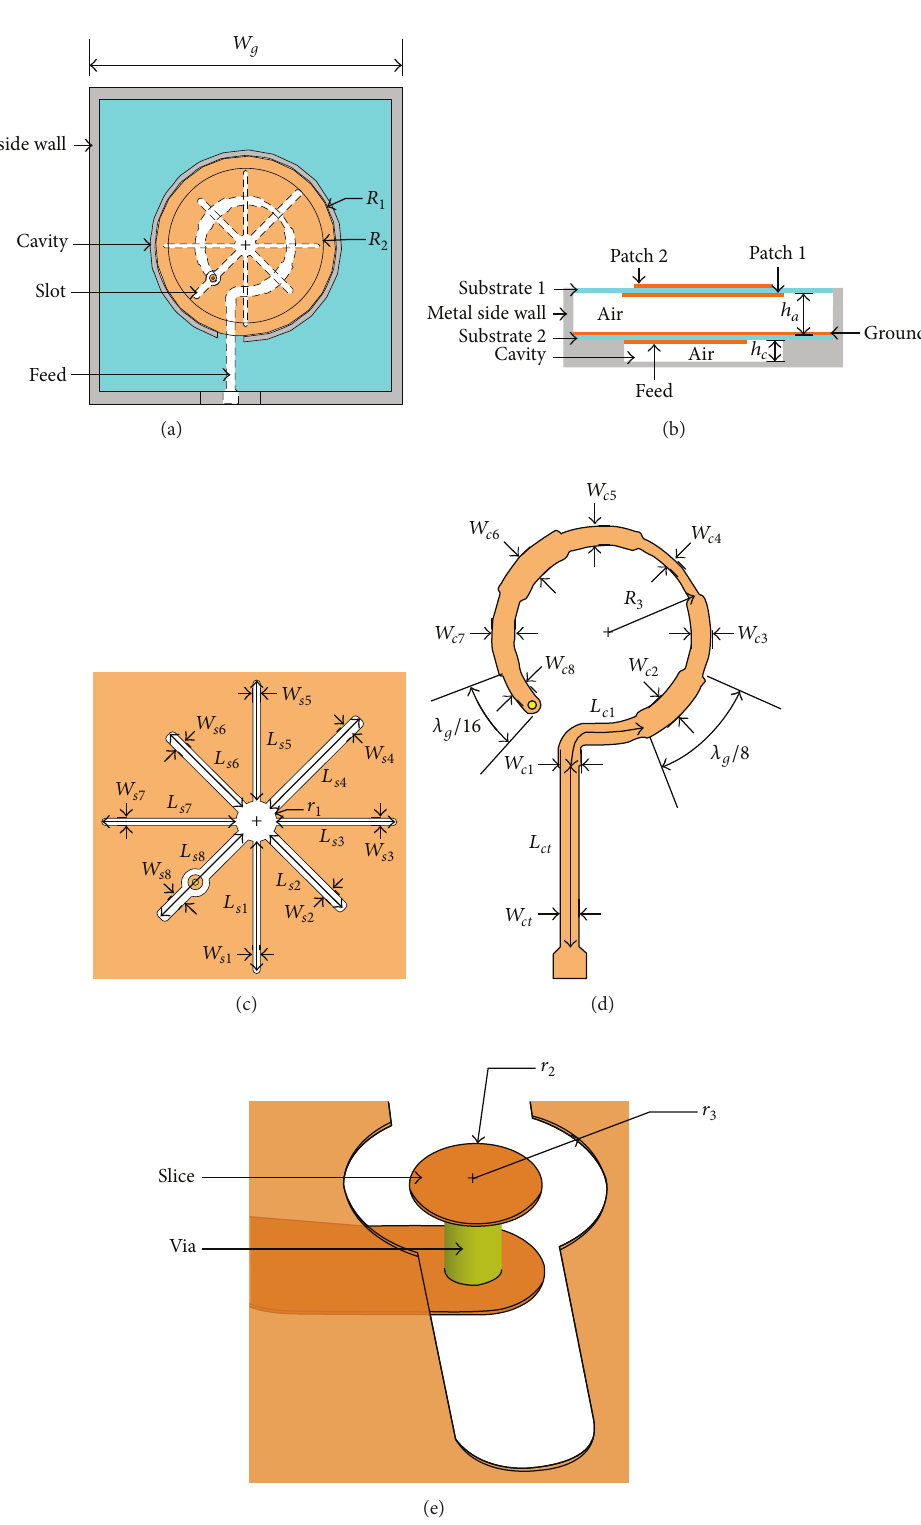
Figure1: Theconfiguration oftheproposedantenna. (a)Thefrontview. (b)Thesideview. (c)Coupling slots.(d)Microstripring. (e)Coupling